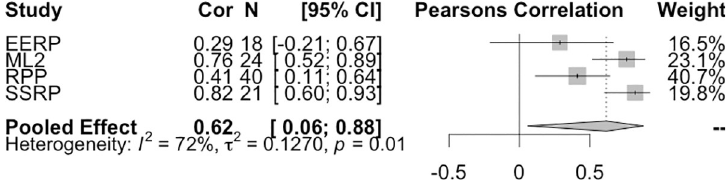
Fig 2. Market price and replication outcome correlation and meta-analysis. Final market price and replication outcome are shown to be correlated in each of the forecasting studies individually. Pooling the correlation using a random effects meta-analysis provides a pooled correlation of 0.62. There is some evidence for heterogeneity between studies with I 2 = 72% (95% CI [20.4%,90.1%]), τ 2 = 0.127 (95% CI [0.007,2.41]) and significant Q statistic (Q(3) = 10.7, p =